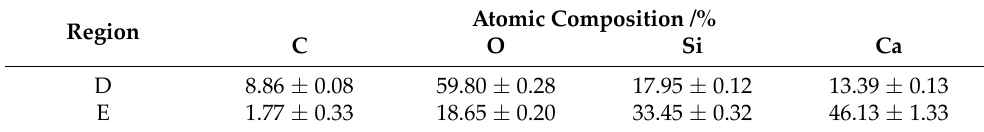
Figure 11. EDS results at region D ( a ) and at region E ( b ). Table 4. EDS results for the marked regions in Figure 10.